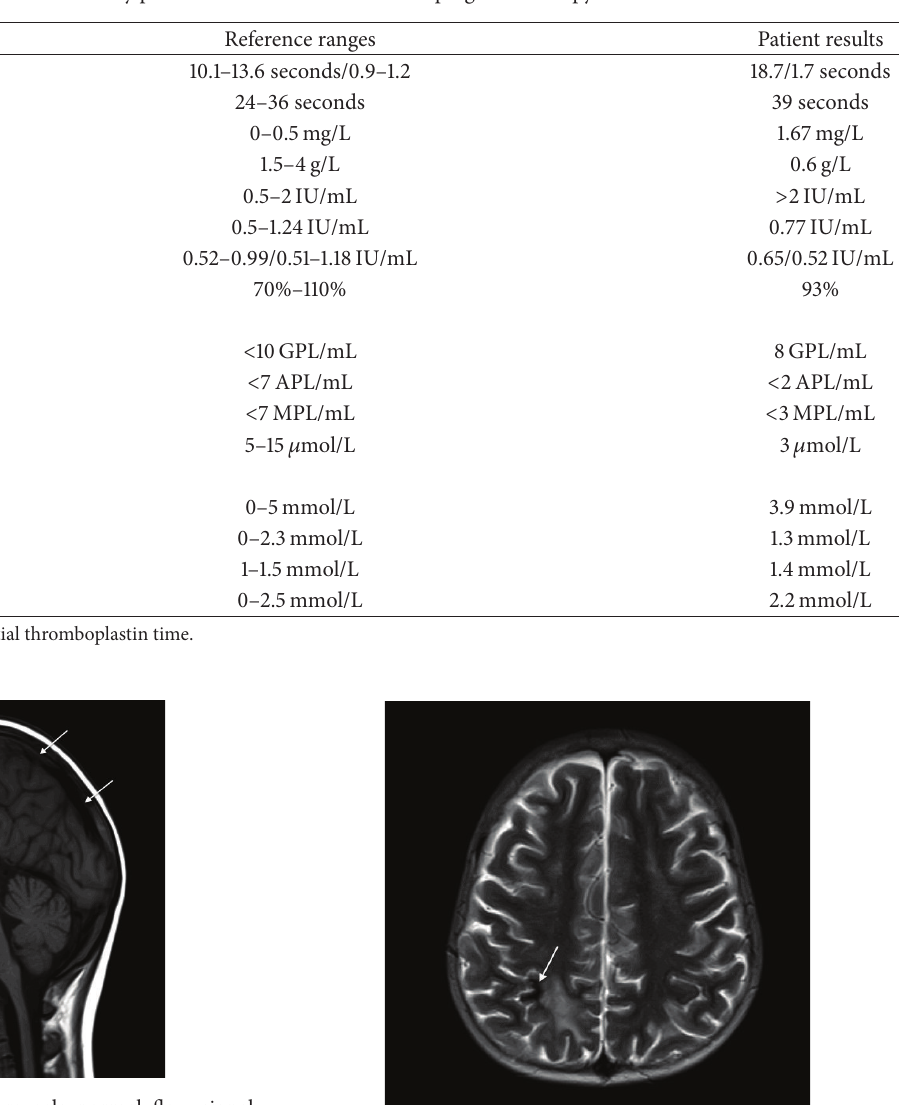
Figure 5: Sagittal T1-weighted MRI reveals normal flow signal indicating total resolution of superior sagittal sinus thrombosis (arrows). Figure 6: Axial T2-weighted MRI showing residual infarct with